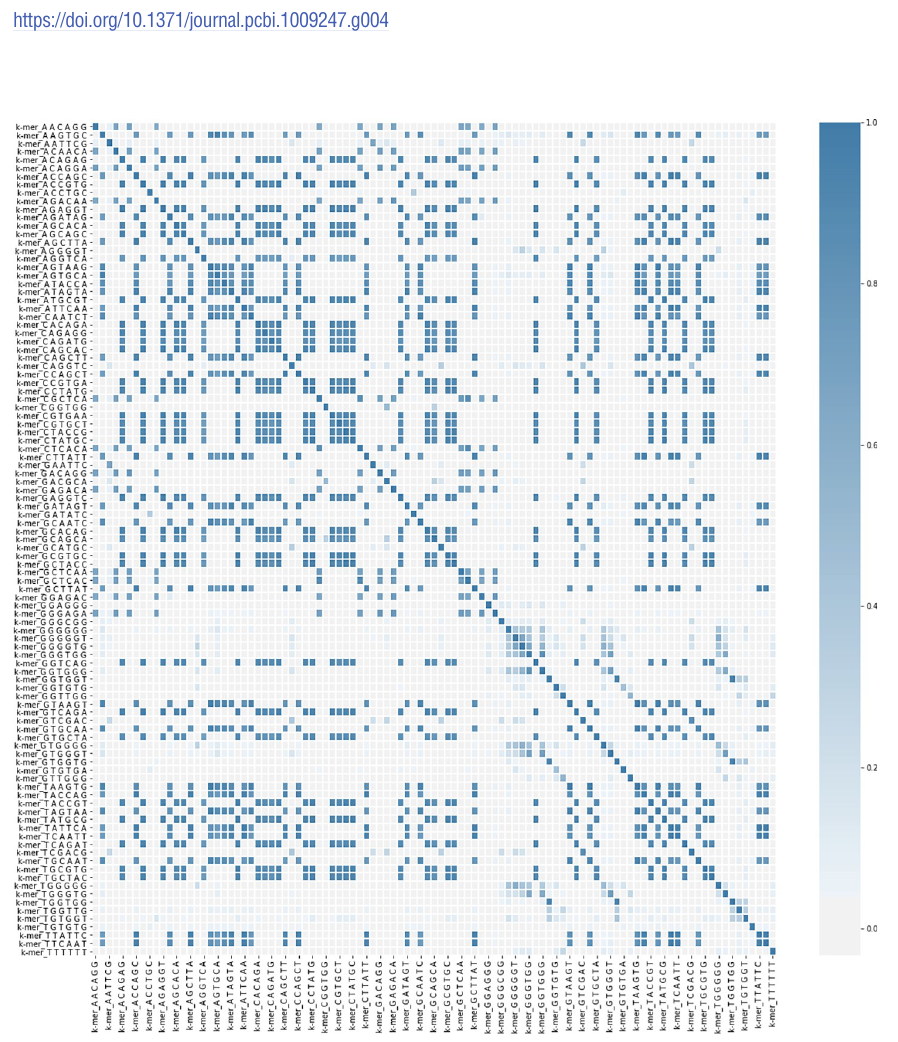
Fig 5. The heatmap of features correlation. The blue diagonal represents a correlation factor equals to one. Blue color means a positive correlation, while white color means no correlation.